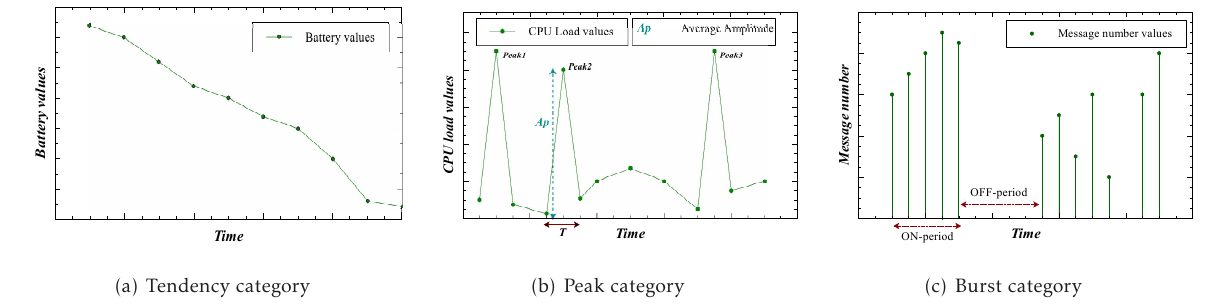
Figure 3. The proposed context categories